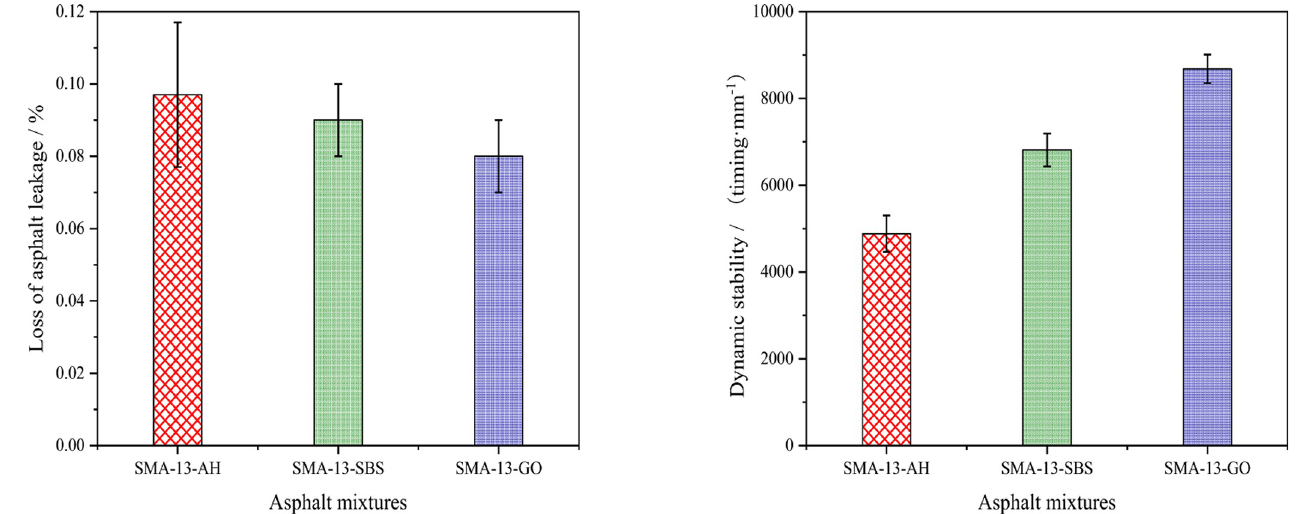
Fig 5. Asphalt mixtures’ high temperature performance. (a) Loss of asphalt leakage. (b) Dynamic stability.